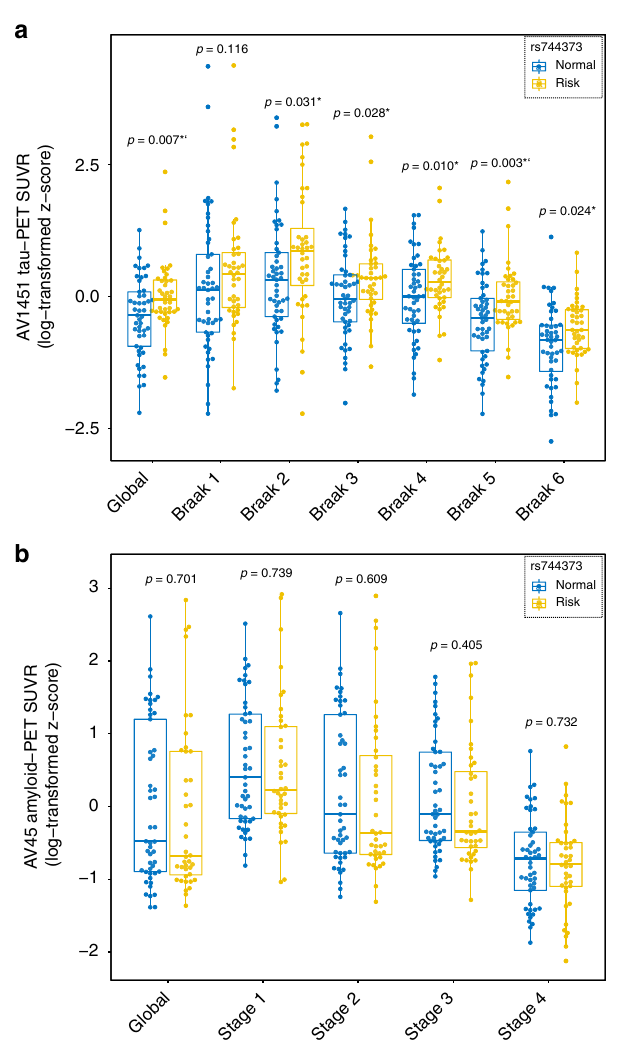
Fig. 2 Effects of BIN1 rs744373 on tau- and amyloid-PET uptake. a Boxplots showing the differences in global or regional AV1451 tau-PET SUVRs between BIN1 rs744373 risk allele ( n = 40, yellow) vs. normal-allele carriers ( n = 49, blue). P -values are based on ANCOVA models controlled for age, gender, education, diagnosis, memory performance (i.e., ADNI- MEM) and gray matter volume of the respective ROI. b Differences in global or regional AV45 amyloid-PET uptake between BIN1 rs744373 risk allele ( n = 40, yellow) vs. normal-allele carriers ( n = 49, blue). Boxplots are displayed as median (center line) ±interquartile range (box boundaries) with whiskers including observations falling within the 1.5 interquartile range. P -values are again derived from ANCOVA models controlled for age, gender, education, diagnosis, ApoE ε 4 carrier status, and gray matter volume of the respective ROI. *p < 0.05 (uncorrected); ‘ = signi fi cant after Bonferroni correction ( p <